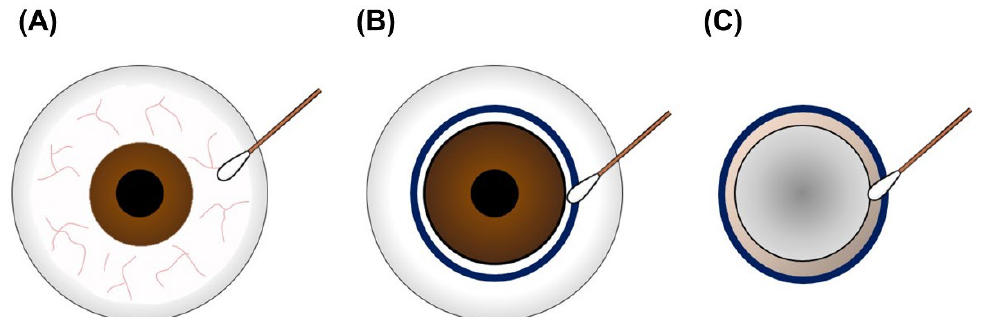
Figure 3. Microbial sampling sites in this study. All microbial sampling was performed using a sterile cotton swab, and the samples were preserved in autoclaved lysogeny broth. ( A ) Pre-surgery microbial samples were collected from the conjunctiva of the ocular surface. Post-surgery samples were collected from the extraocular corneal limbus ( B ) and intraocular corneoscleral rim ( C ) for surgical contamination analysis.